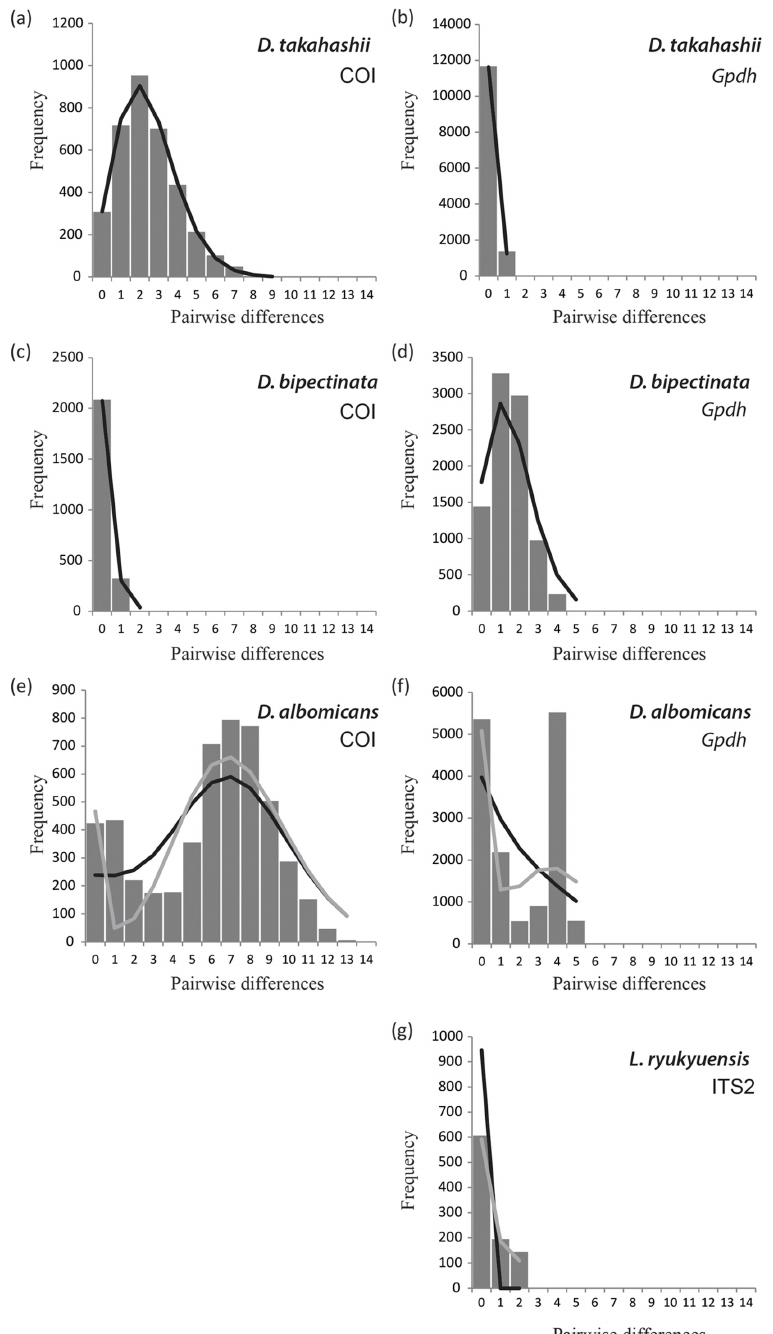
Fig 4. Pairwise mismatch distribution calculated for mitochondrial and nuclear markers of the four study species. Solid histograms represent observed differences, black line the expected distribution compatible with a sudden-expansion model, and gray line the distribution compatible with the spatial expansion model. Where both models overlap, only the black line is shown.